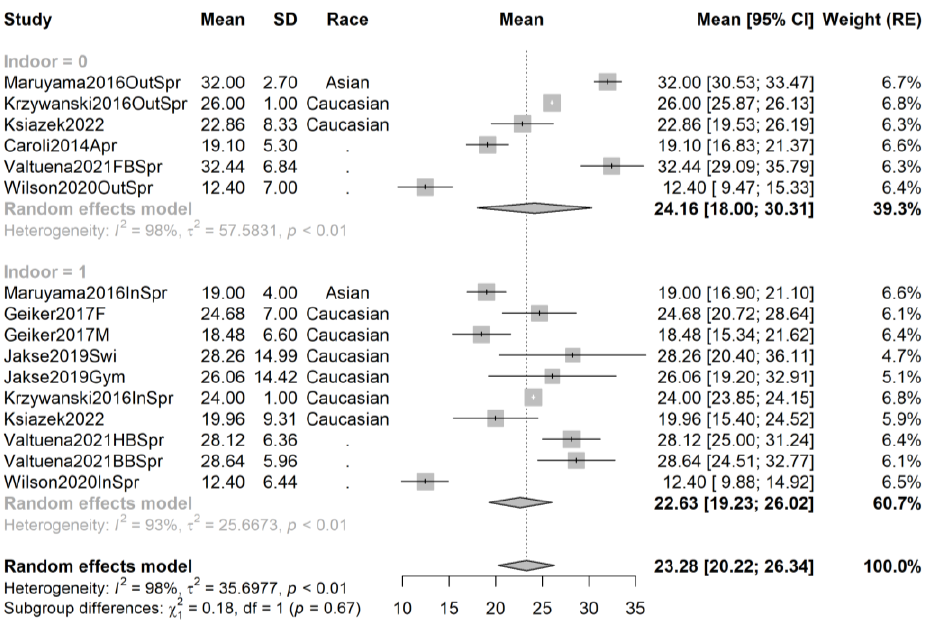
Figure 6. Forest plot of all studies performed in spring sorted by athletes’ race. Studies [44,46,50,61,66,67,69,70].